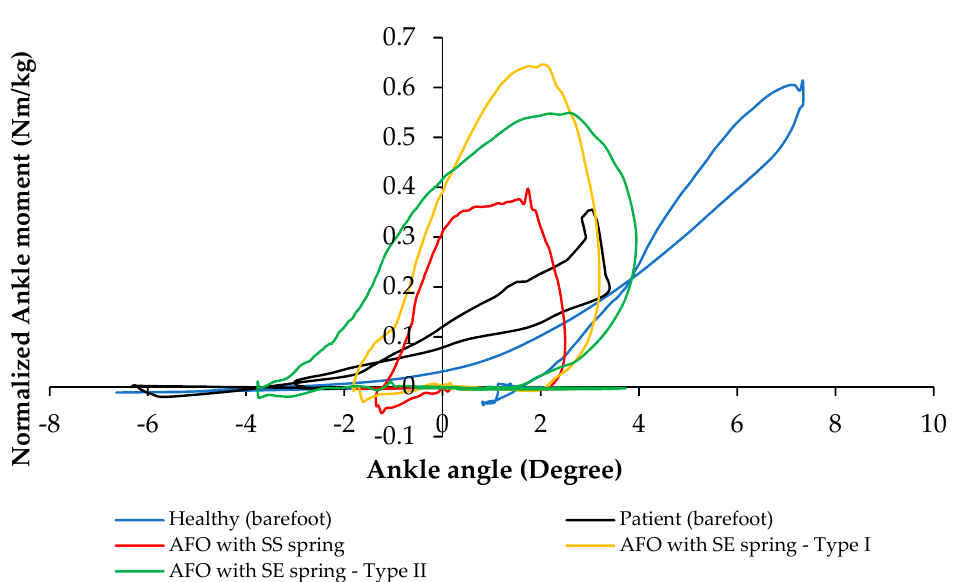
Figure 15. Ankle torque-angle loop during normal walking (blue), AFO with Stainless Steel spring (red), AFO with superelastic NiTi spring and diameter of 0.68 mm (yellow), and AFO with superelastic NiTi spring and diameter of 1.07 mm (green) (Case ІІ ) [42]. Ground reaction forces have been illustrated with respect to frame number during normal walking using AFO with Stainless Steel spring, AFO with superelastic NiTi spring (0.68 mm), and AFO with superelastic NiTi spring (1.07 mm) Figure 16.